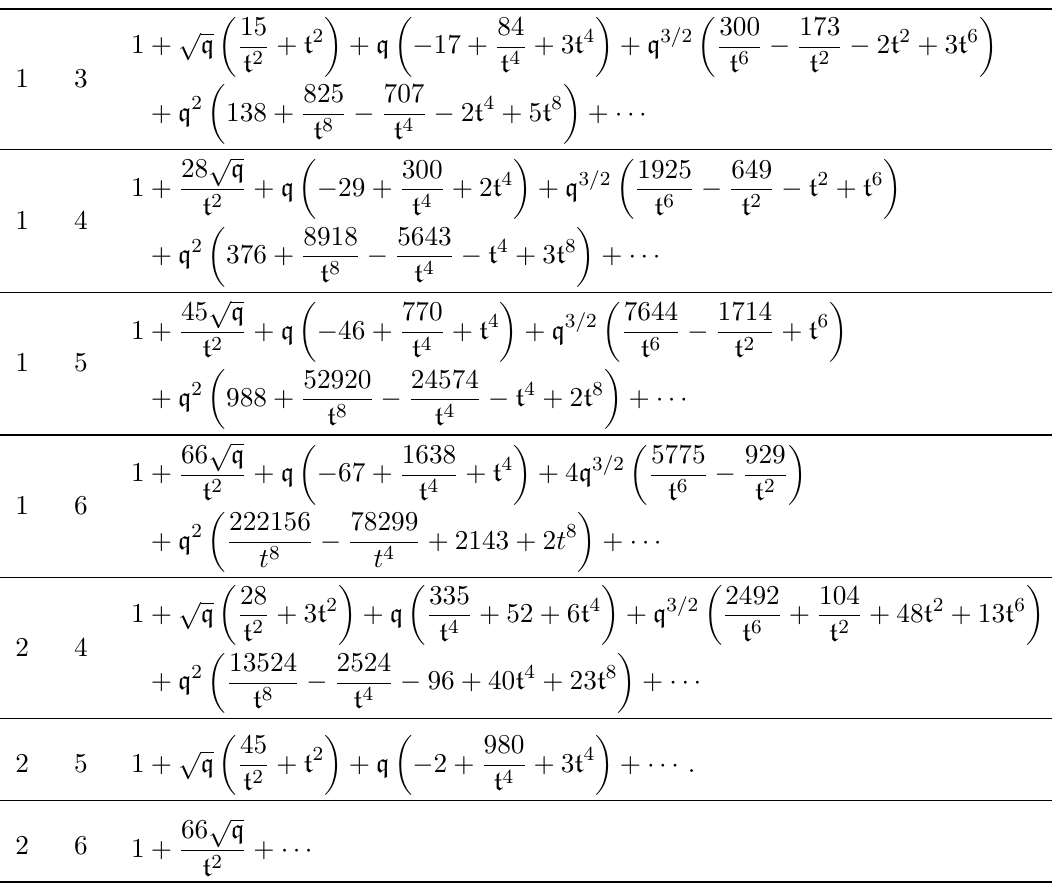
Table 3. Superconformal index for the unitary and orthosymplectic mirrors of Sp( k ) with N f